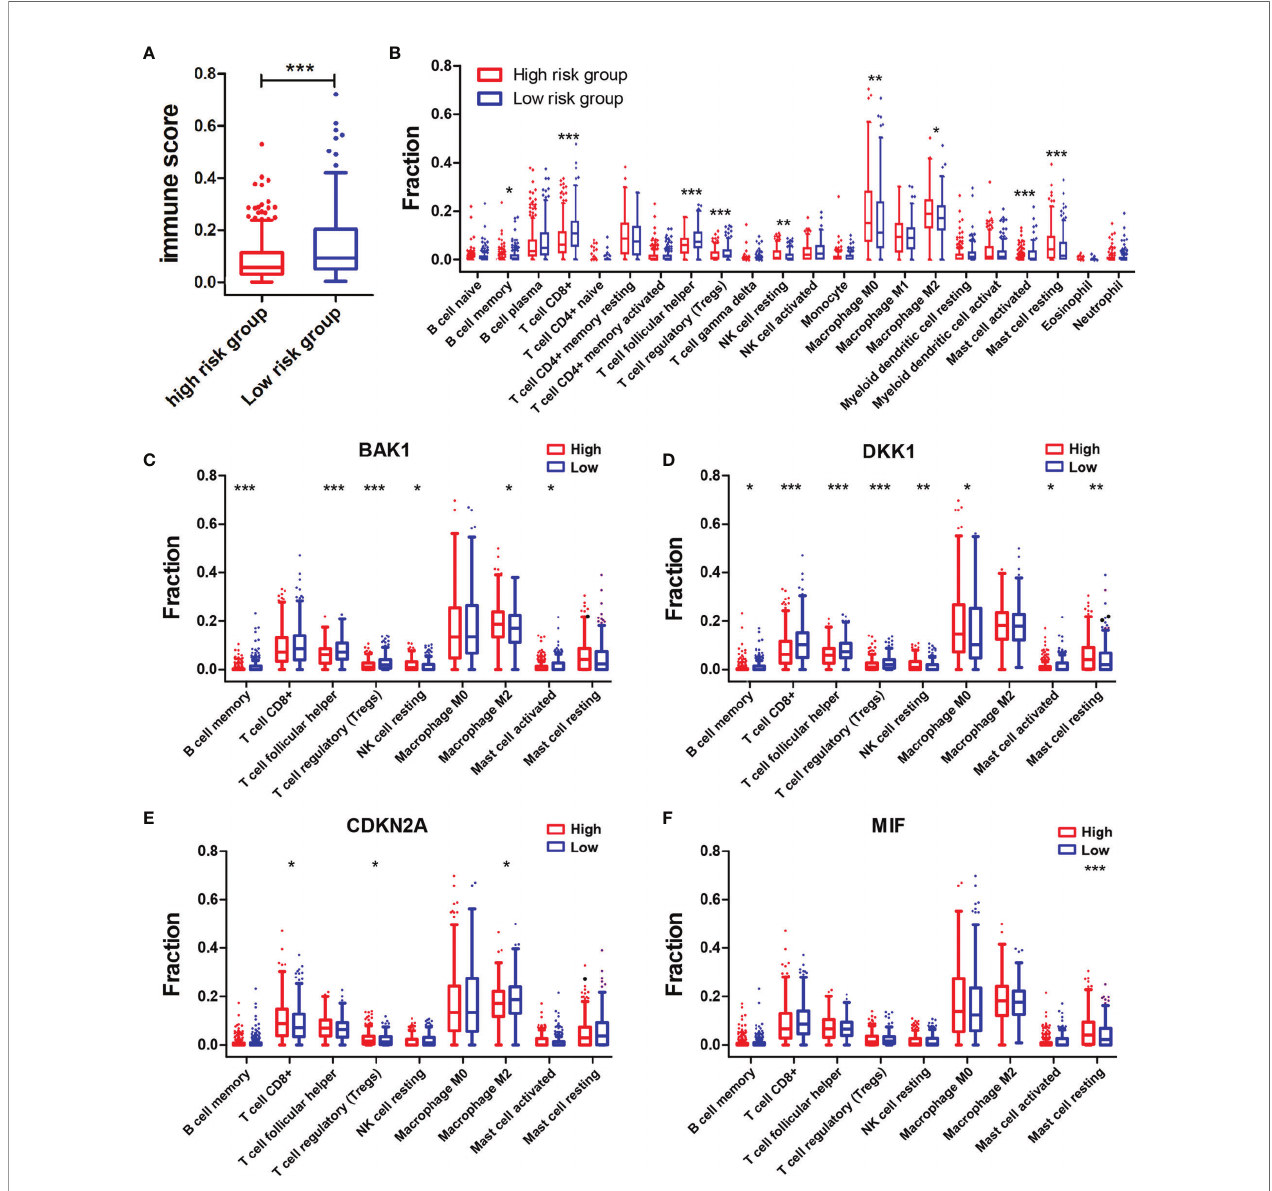
FIGURE 6 | Associations of immune cell in fi ltration level with the risk score and the four selected AGs. (A) Comparison of immune scores in the high-risk and low-risk groups. (B) Comparison of compositional fractions of 22 types of immune cells between the high-risk and low-risk groups evaluated using the CIBERSORT formula. (C – F) Comparison of in fi ltration levels of nine types of immune cells according to BAK1 (C) , DKK1 (D) , CDKN2A (E) , and MIF (F) expression levels. * p < 0.05, ** p < 0.01, and *** p <